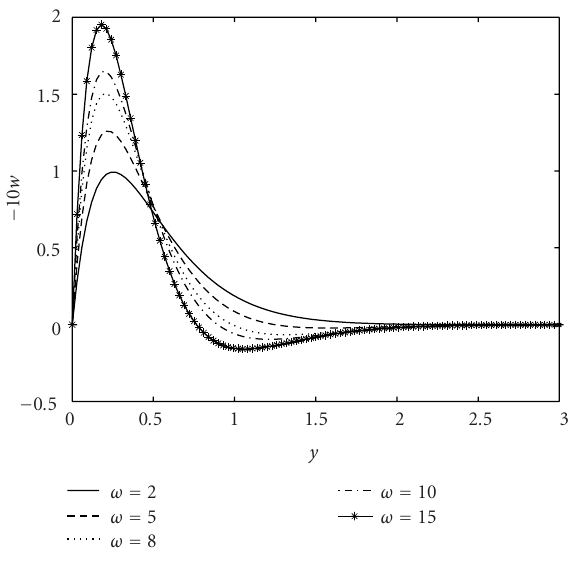
Figure 4.4. Cross-velocity − 10 × w for Gr = 5 . 0, S = 1 . 0, z = 0 . 2, t = 0 . 2, (cid:2) = 0 .